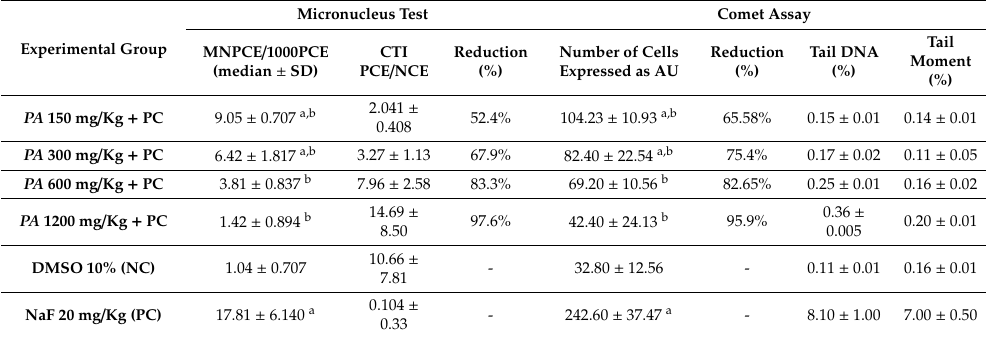
Table 2. Genotoxicity study: Micronucleus test and Comet